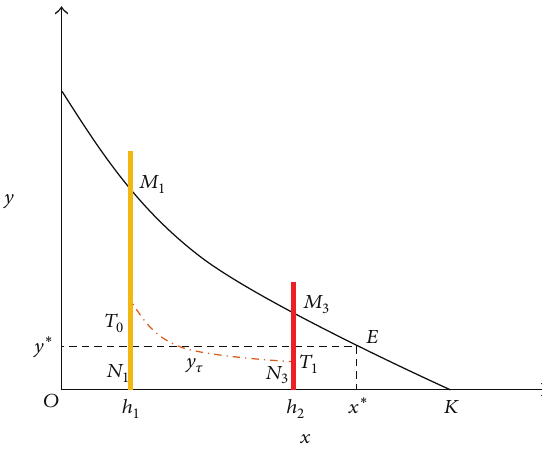
Figure 1: The system structural